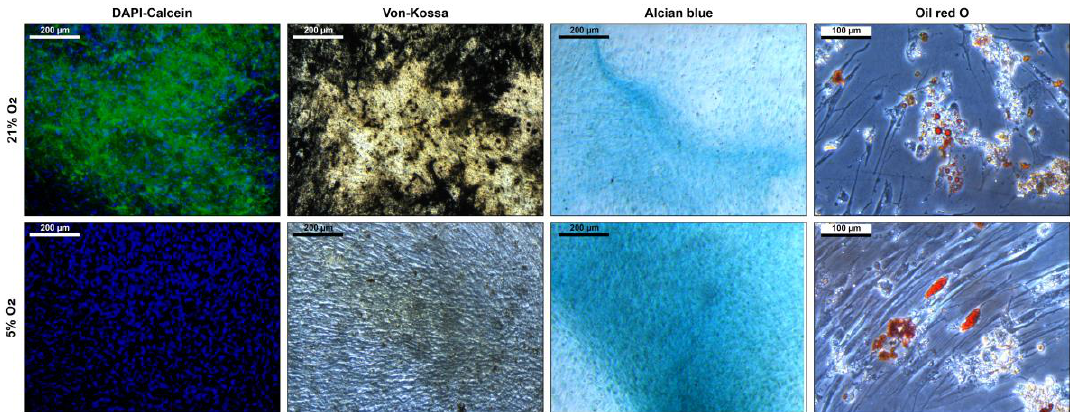
Figure 5. Differentiation of mesenchymal stem cells after six days cultivation under 21% and 5% O 2 in a continuously stirred tank reactor. Osteogenic differentiation is indicated by DAPI-calcein staining for nuclei and extracellular calcium and von Kossa stain for extracellular phosphates. Chondrogenic differentiation is indicated by alcian blue staining which stains for glycosaminoglycans. Adipogenic differentiation is indicated by Oil Red O staining which stains the intracellular fatty vacuoles.